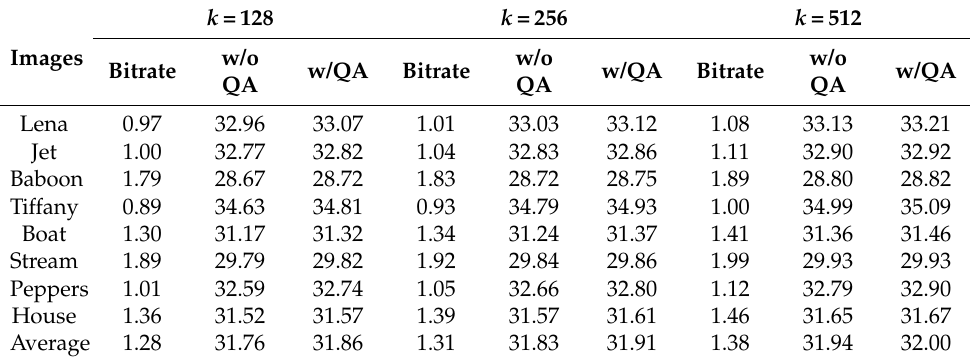
Table 3. PSNR and bitrate of compressed images with 8 × 8 block